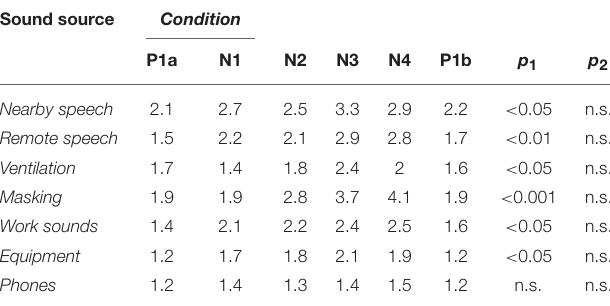
TABLE 4 | Perceived disturbance by various environmental factors.